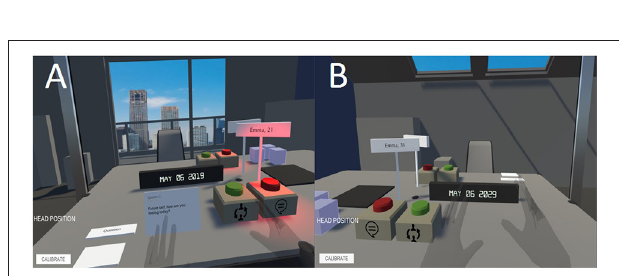
FIGURE 2 | The process of the perspective taking exercise. Participants in the present self (A) pick up a question card and press the red button to record the question. Participants then press the green button to switch chairs to the future self perspective (B) . As their future self, they press the red button